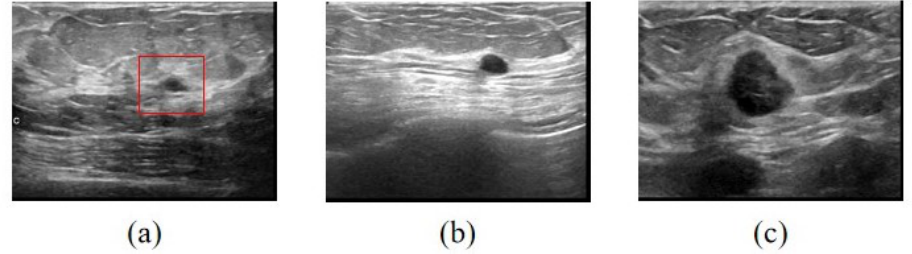
Figure 8. Database images. ( a ) Normal image with region marked in red that resembles a benign nodule. ( b ) Image with a benign nodule. ( c ) Image with malignant